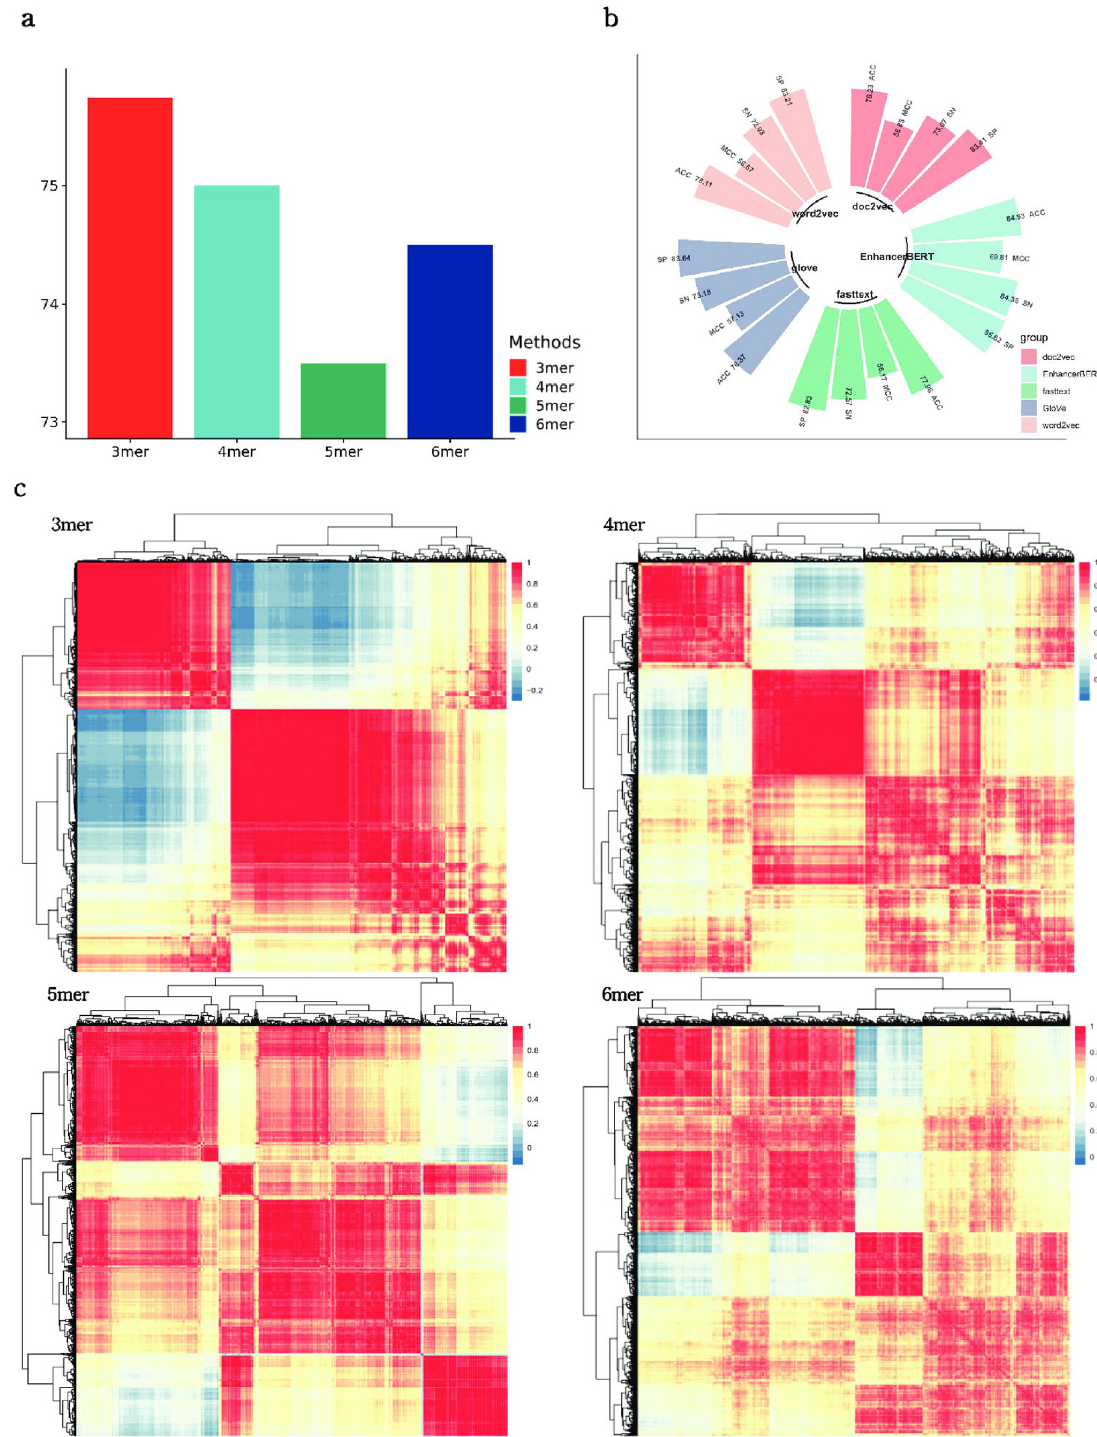
Fig 4. (a) ACC performance of different k-mer EnhancerBERT models, where the 3mer-model achieves the best performance over all models; (b) values of four metrics for assessing performance of EnhancerBERT versus the different NLP technologies, showing that dynamic semantic information in EnhancerBERT has the best characterization capability; (c) compares degree of correlation of different k-mer dynamic semantic information using Pearson correlation coefficient, 3mer-model has the clearest correlationship between features, which support SMFM in identifying